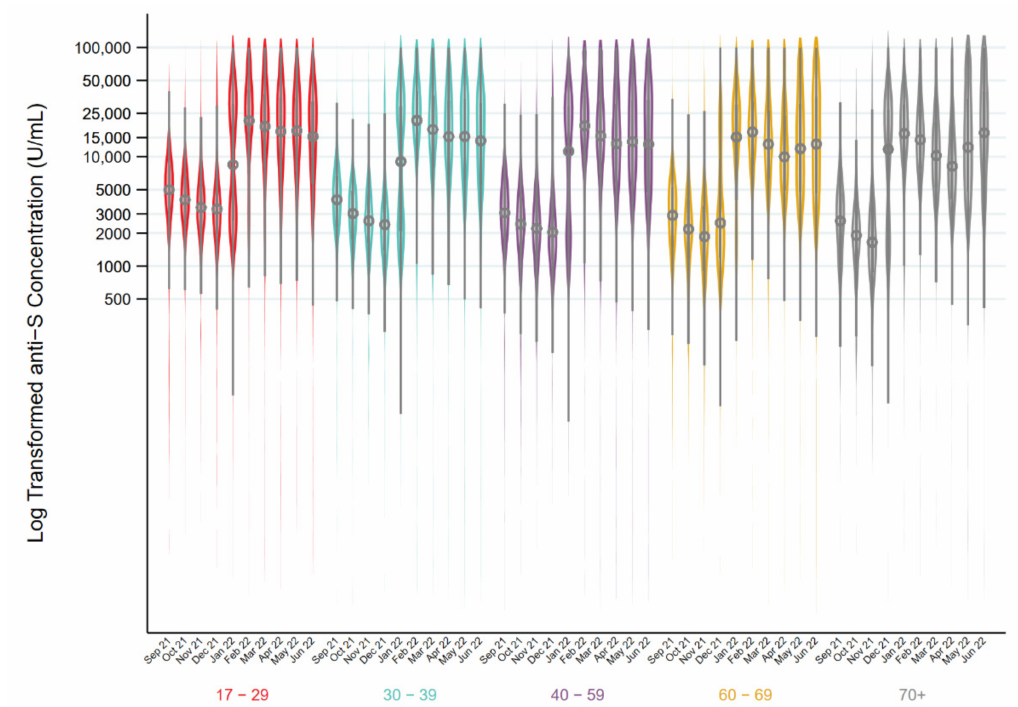
Figure 3. Distributions of log transformed Spike antibody concentration results (U/mL) (circle represents the median and the bar represents the interquartile range) in donations from September 2021 to June 2022 stratified by age group.